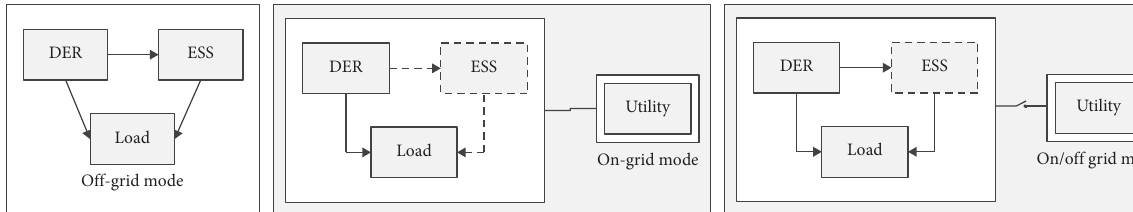
Figure 1: Modes of